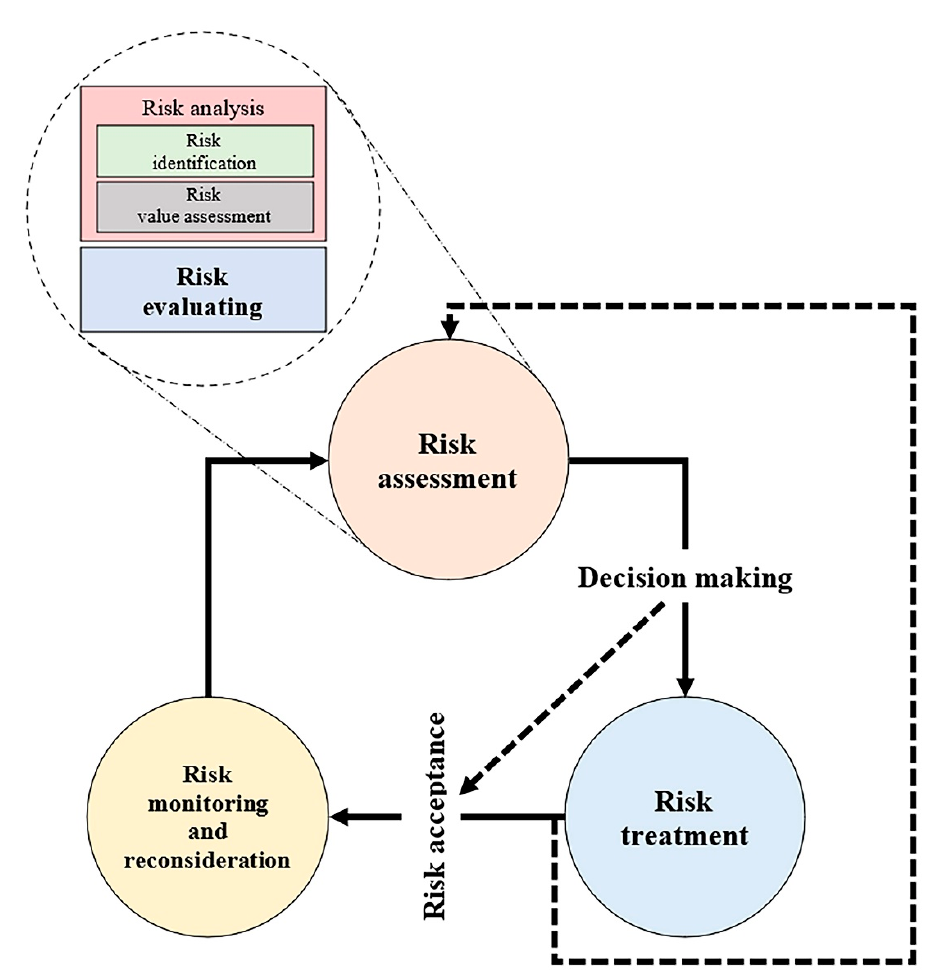
Figure 2. Interconnection between the risk management stages.